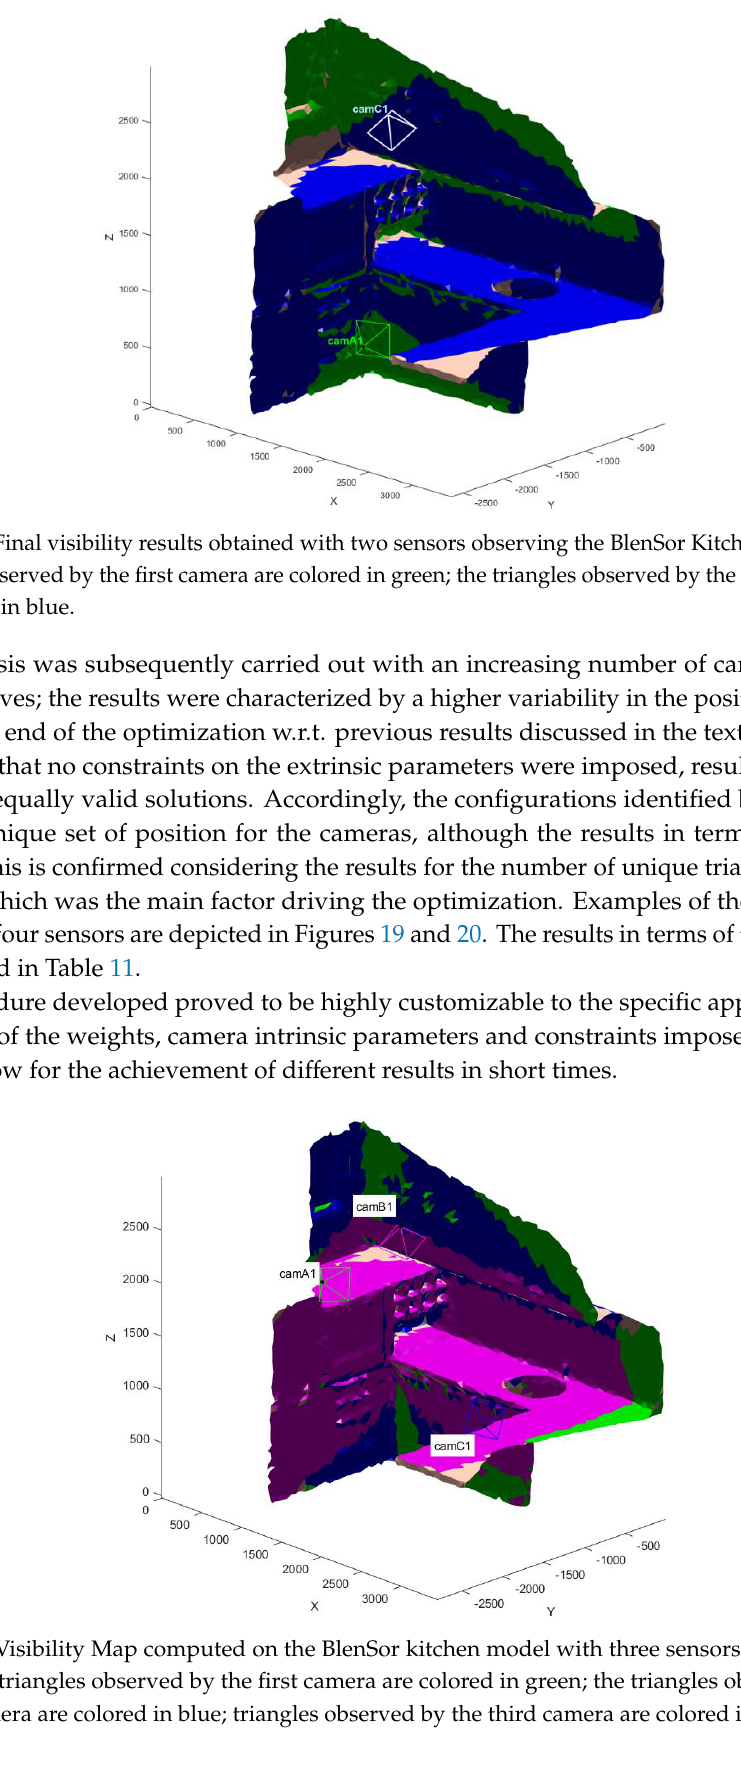
Figure 20. Original reference data extracted from the BlendSor database — kitchen model. The triangles observed by the first camera are colored in green; the triangles observed by the second camera are colored in blue. 4 . Discussion and Conclusions A procedure to perform an optimization search for the best extrinsic parameters of a set of optical sensors observing a known scene has been presented in this article. The method can model both 2D and 3D sensors, thanks to an updated version of the classic pin-hole camera model, which is processed with a series of filters to assure i) good computational performances of the model, ii) a valid representation of triangulation-based optical 3D sensors. The development of an optimization